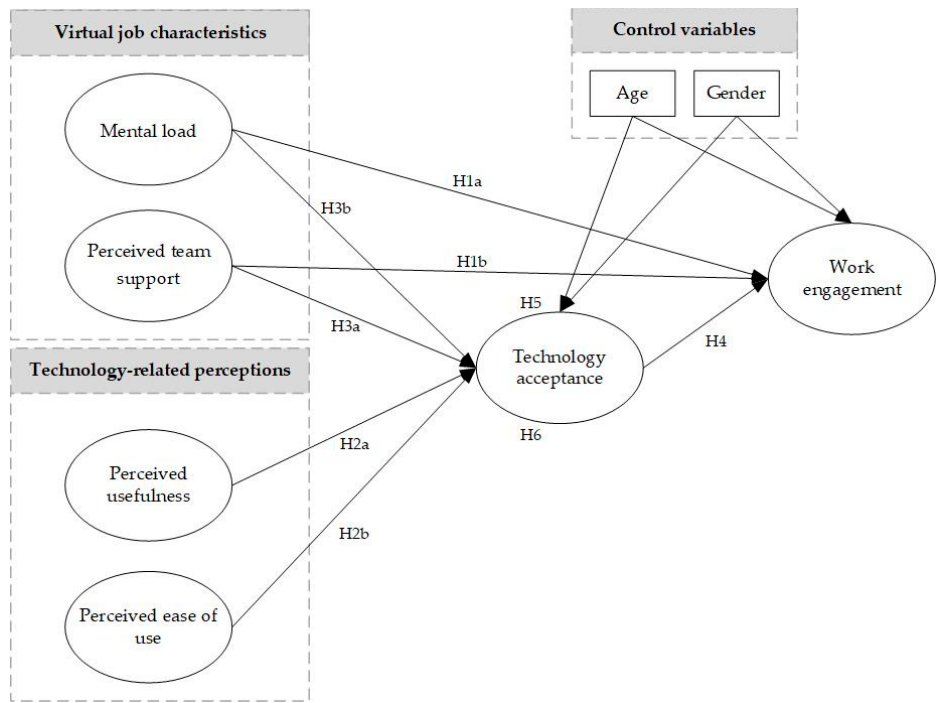
Figure 1. The conceptual framework of the study.